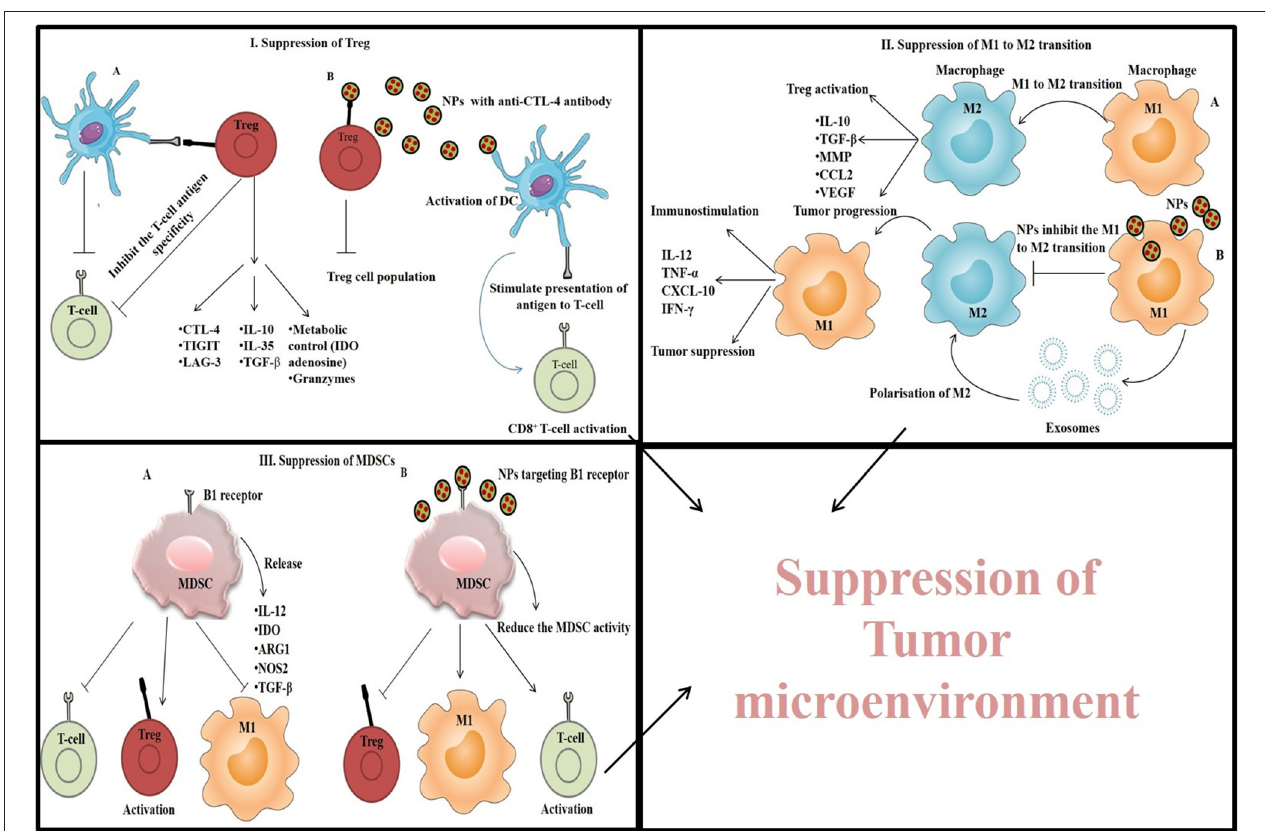
FIGURE 6 | Immunostimulatory NPs mediated TME suppression by (I) targeting Treg and suppressing its function, (II) by inhibiting M1 to M2 transition of macrophages, and (III) by suppressing the MDSC cells.